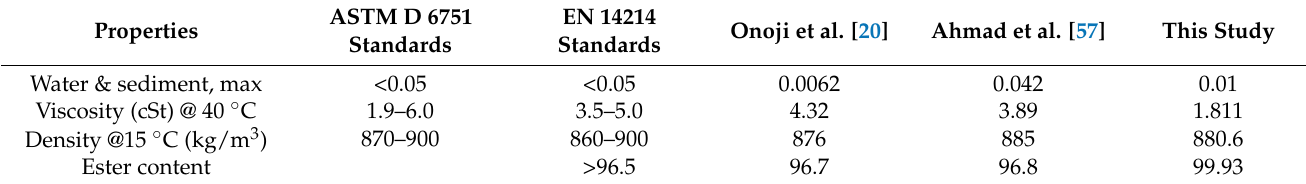
Table 7. Product properties obtained from this study in comparison with other products from the literature.